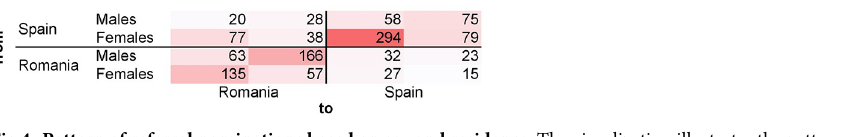
Fig 4. Pattern of referral nominations based on sex and residence. The visualization illustrates the pattern of referral nominations, based on sex and place of residence. For instance, the female respondents living in Romania (Daˆmbovi ț a) (see the “from” axis) indicated as referrals (see the “to” axis): 135 and 57 males living in Romania (Daˆmbovi ț a), 27 females and 15 males living in Spain (Castello´n).